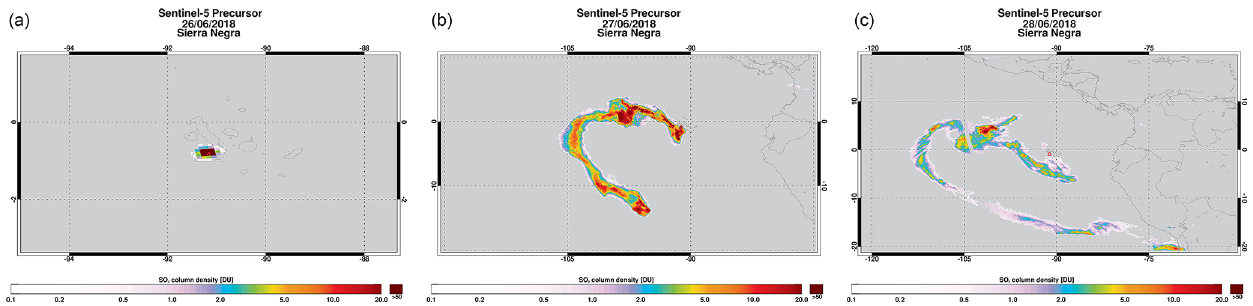
Figure 9. SO 2 VCD for the TROPOMI measurements of the Sierra Negra volcano from 26 (a) to 28 June 2018 (b) , with overpass times of around 19:50UTC.